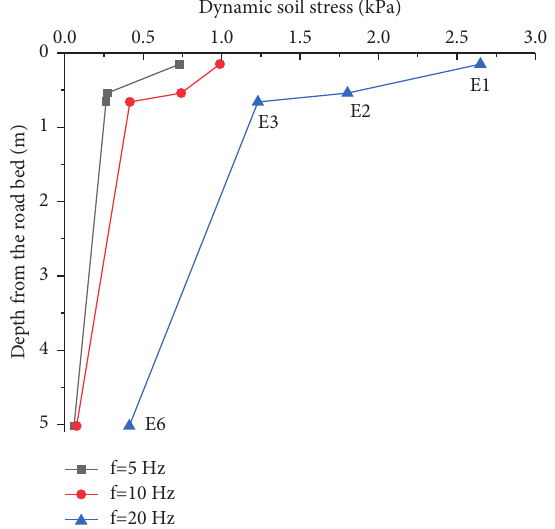
Figure 16: Distribution of dynamic soil stresses in the track substructure (embankment, raft, cushion, and